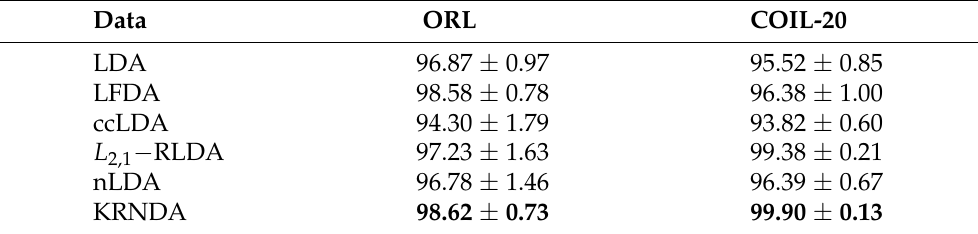
Table 5. The accuracy (%) comparison of ORL and COIL-20 datasets recognition